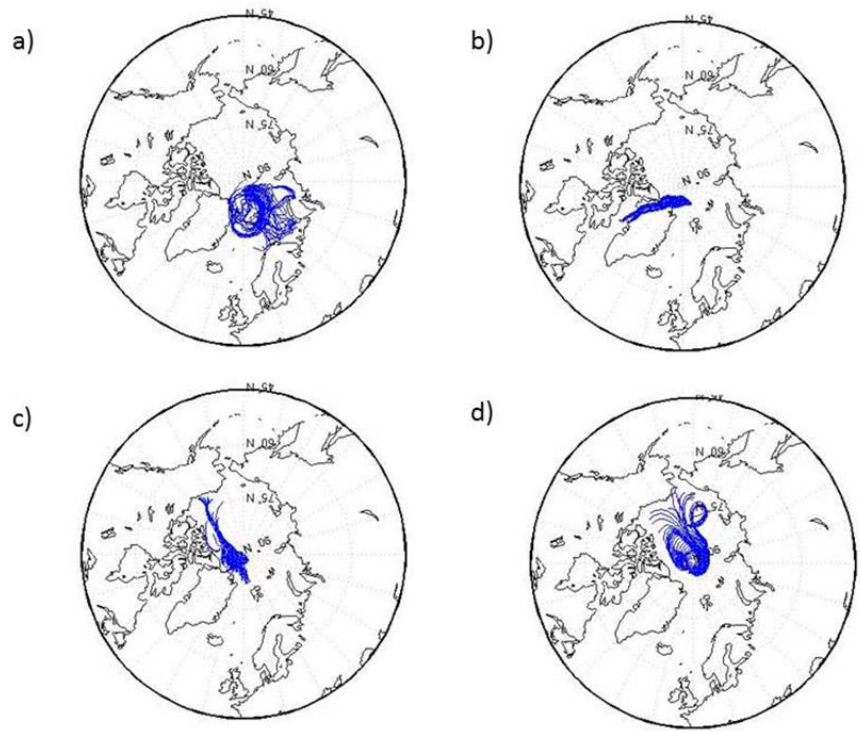
Fig. 4. Air mass trajectory probability source contribution function calculated for 100m altitude: (a) period 1, (b) period 2, (c) period 3 and (d) period